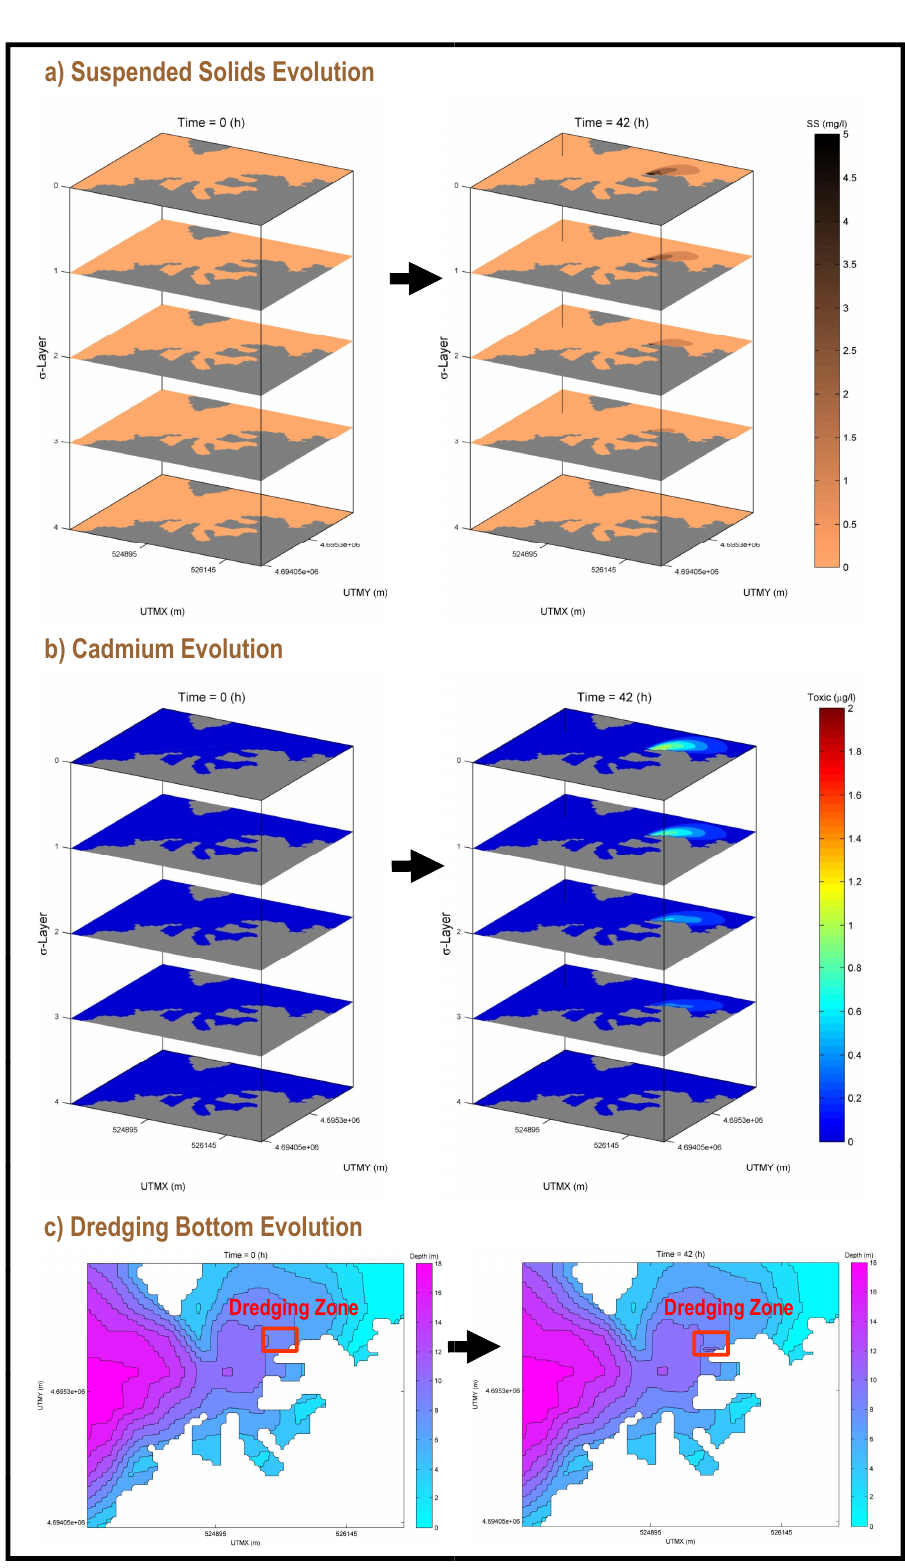
Fig. 3. (a) Suspension solids evolution during dredging process. (b) Cadmium concentration evolution during dredging process. (c) Depth evolution in the study area during dredging